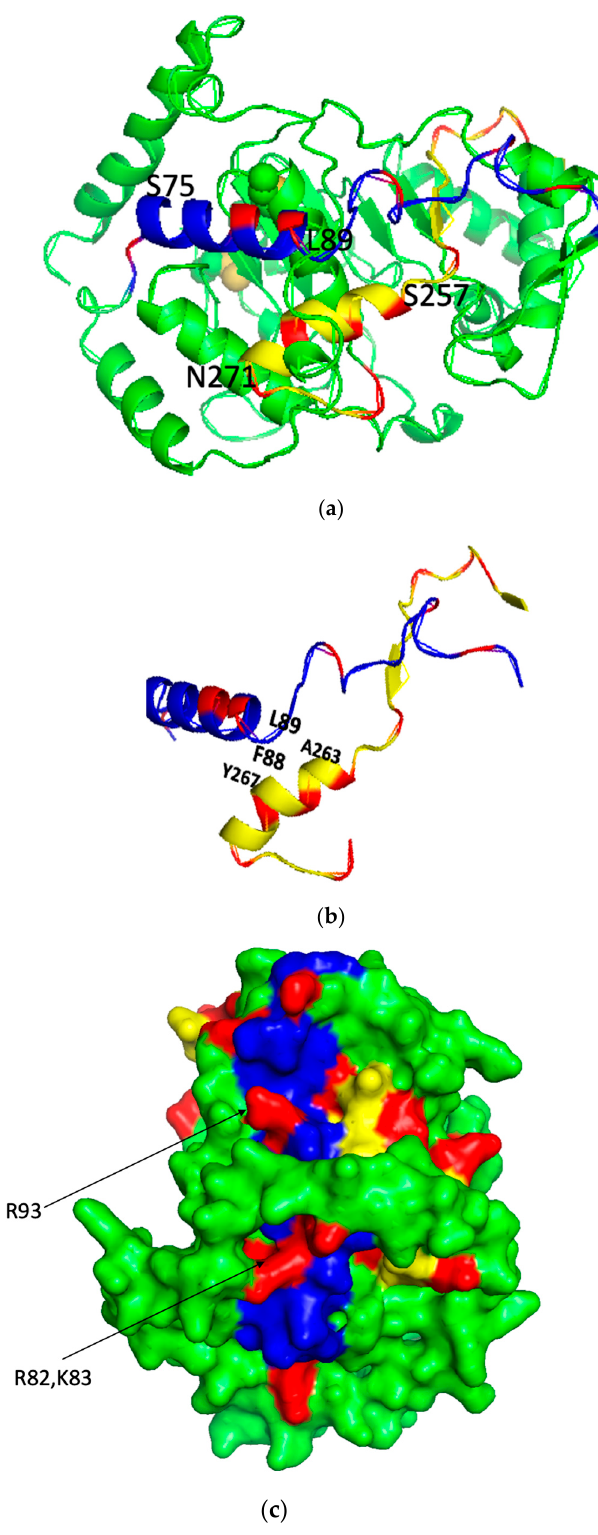
Figure 1. The predicted 3D backbone model of human ST8SiaIV was generated using Phyre2 sever [46] ( a ), the extracted PBR (blue) and PSTD (yellow) backbone motifs from the model ( a ) is shown in ( b ) and the surface model of the ST8Sia IV is displayed in ( c ). All basic residues are labeled in red. Above models were displayed using PyMol 2.5.